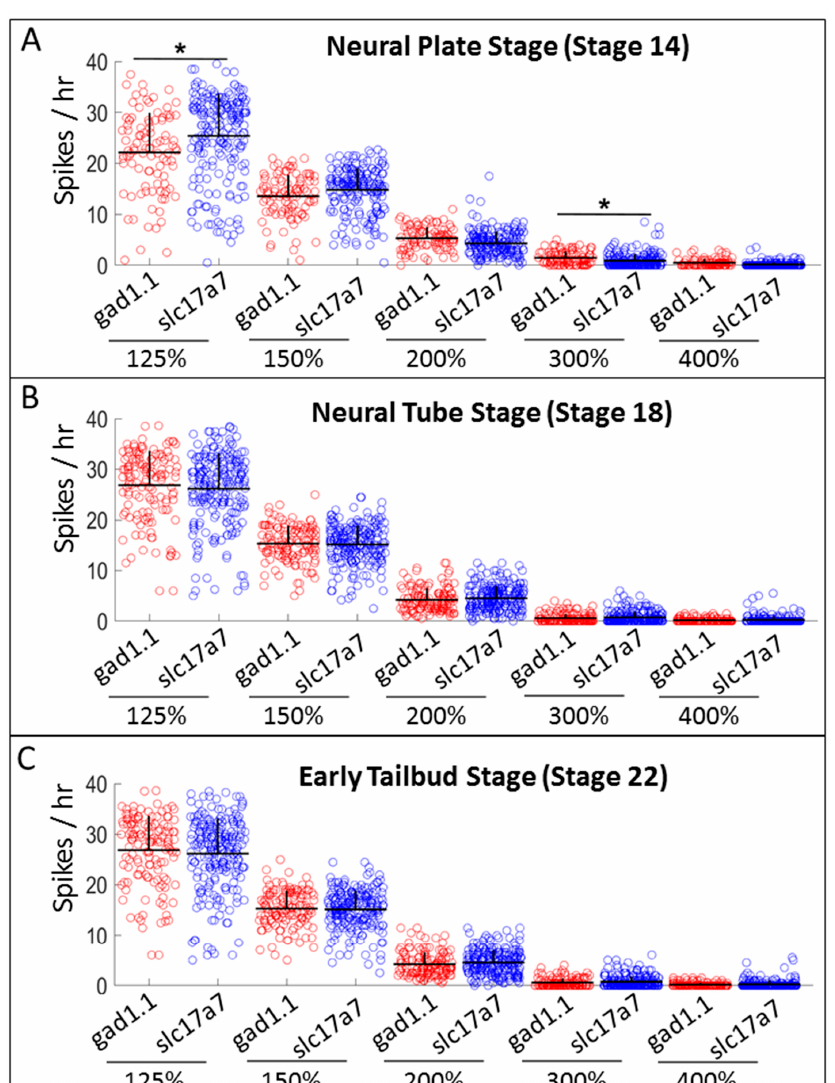
Figure 2. Presumptive glutamatergic cells dissected at neural plate stage of development show more low-level spiking activity, while presumptive GABAergic cells display higher-amplitude spiking. Comparison of spiking frequency counted using five different thresholds (125%, 150%, 200%, 300% and 400% of baseline), between inhibitory ( gad1.1 ) and excitatory ( slc17a7 ) neurons at: ( A ) neural plate stage (Stage 14); ( B ) neural tube stage (Stage 18); and ( C ) early tailbud stage (Stage 22). Stars represent statistically significant differences according to both Bonferroni-corrected two-sample Kolmogorov–Smirnov Test ( p < 0.05) and Cohen’s d statistics for effect size (mean + SD; n = 5 cultures; * 0.2 ≤ |d| < 0.5, ** 0.5 ≤ |d|< 0.8, *** |d| ≥ 0.8).